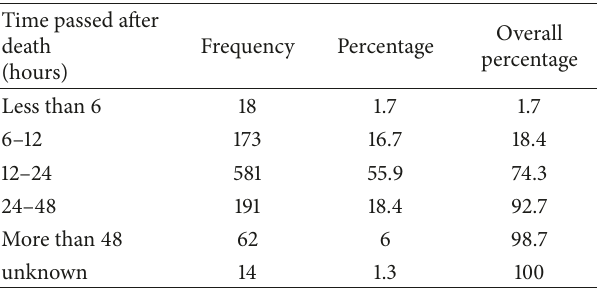
Table 2: Frequency distribution of the time passed since death in the studied